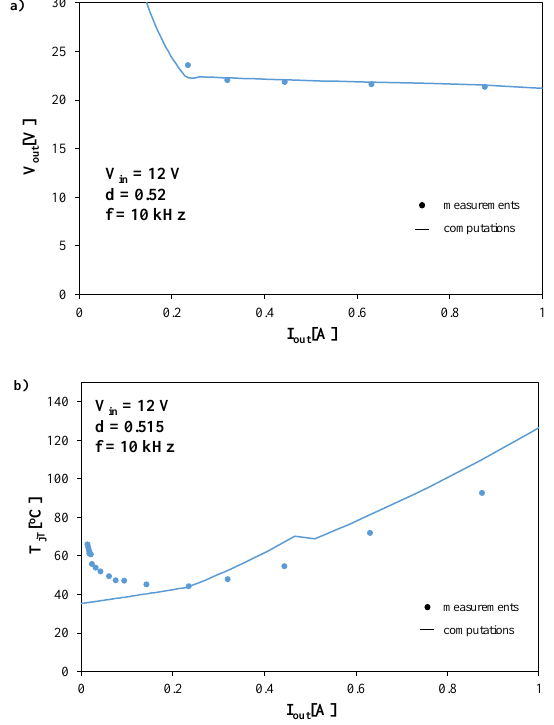
Figure 15. Measured and computed dependences of the output voltage ( a ) and the IGBT junction temperatures ( b ) on the output current of the investigated converter.